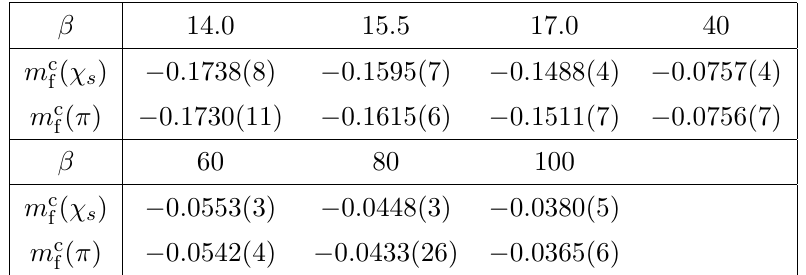
Table 3. Critical fermion mass m c for di(cid:11)erent (cid:12) . To determine the mass we use the chiral f susceptibility and the mass of the pion ground state.